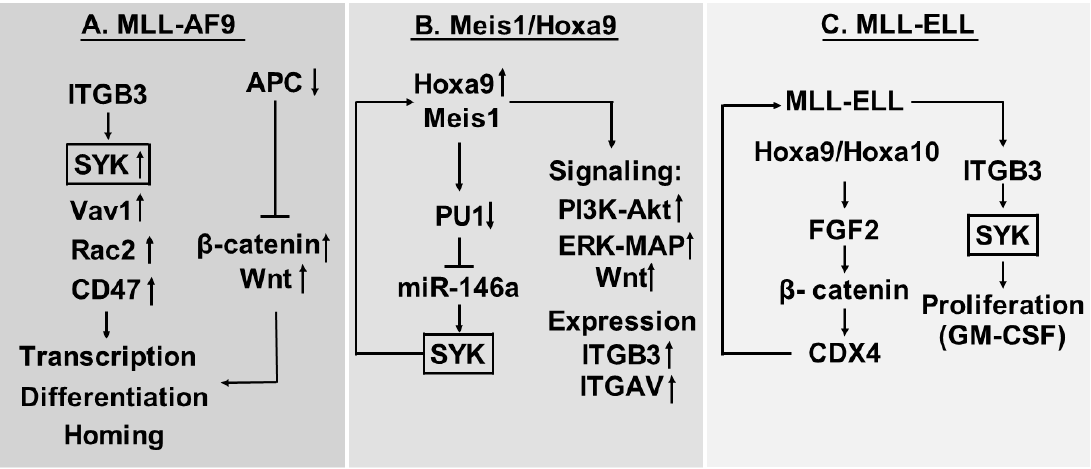
Figure 2. Animal models of AML—a summary of the MLL-AF9 ( A ), Meis1-HoxA9 ( B ) and MLL-ELL ( C ) murine models. For additional details and references, see the text.